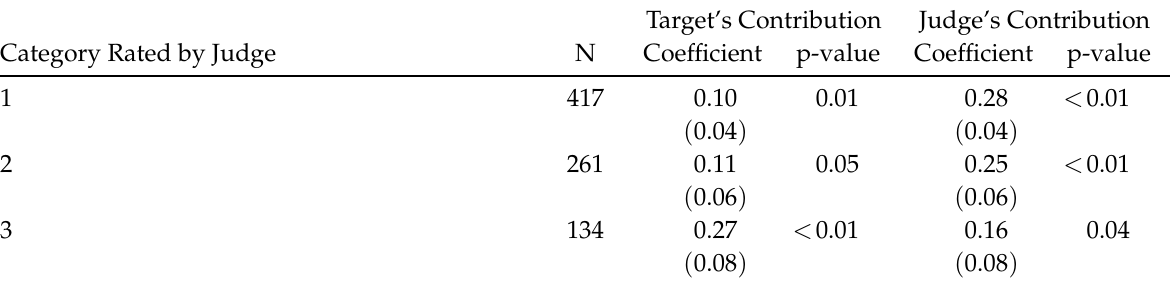
Table 3: Regression of judge’s prediction on target’s contribution and judge’s